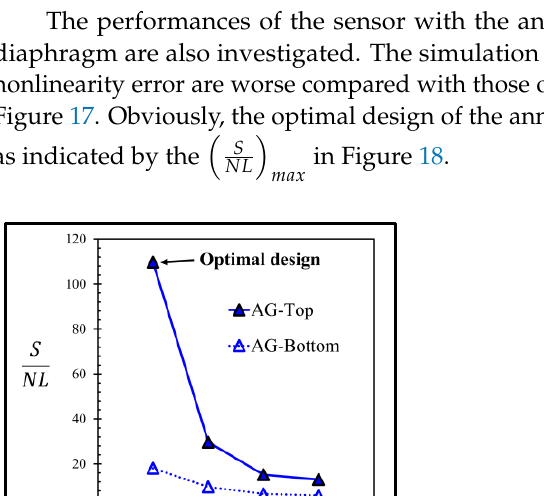
Figure 17. Variations of ( a ) sensitivity and ( b ) nonlinearity error with dimensionless groove depth of sensors with annular grove 𝐴𝐺 created on the top (solid line) and at the bottom (dotted line) of diaphragm.